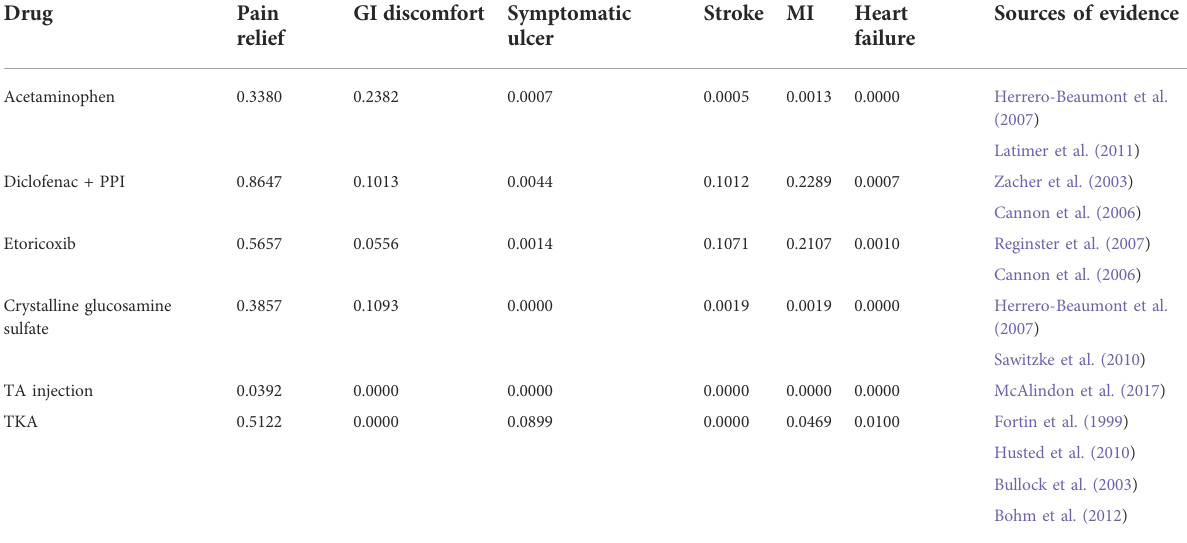
TABLE 1 Base-case probability estimates and ranges over a period of 6